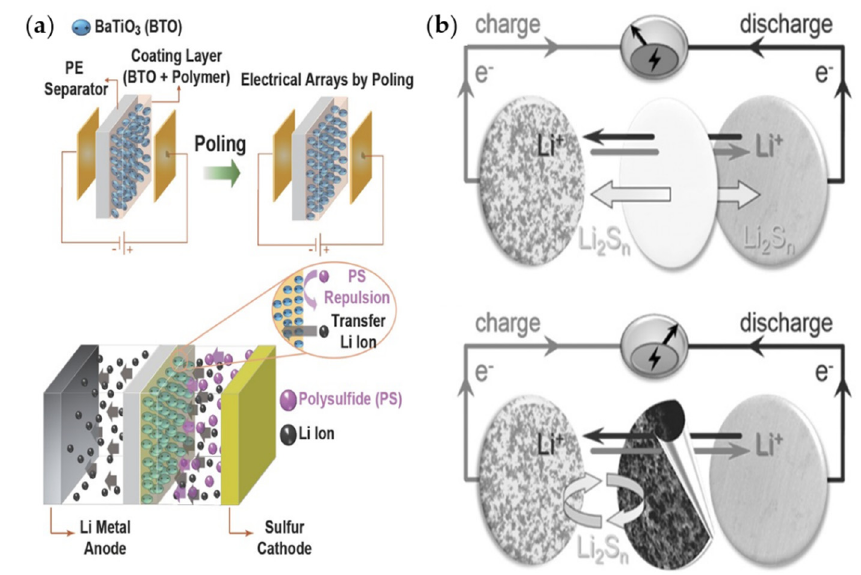
Figure 11. ( a ) Schematic of the poling process of the BTO-coated PE separator and the effect of